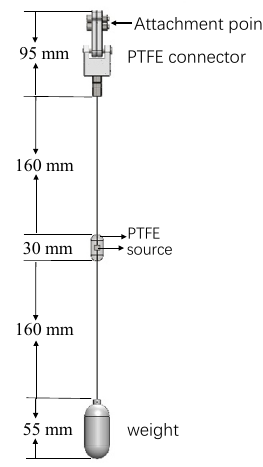
Figure 4 . Design of a typical source assembly. The 6 × 6 mm 2 stainless steel source capsule is enclosed in a 30 mm high PTFE shell.